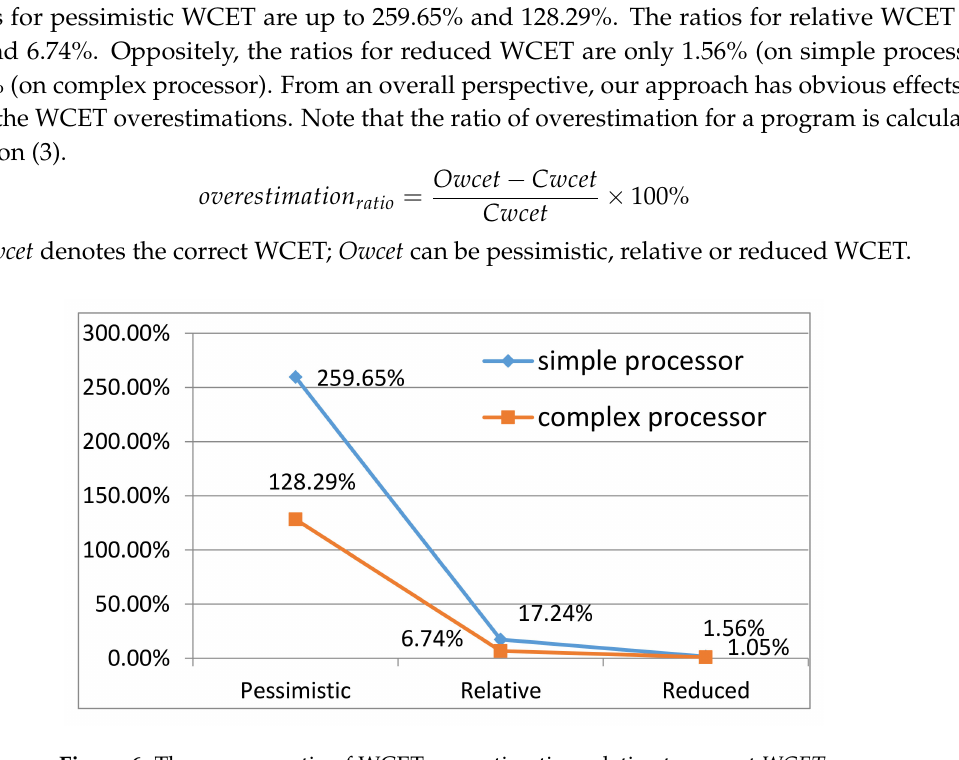
Figure 6. The average ratio of WCET overestimation relative to correct